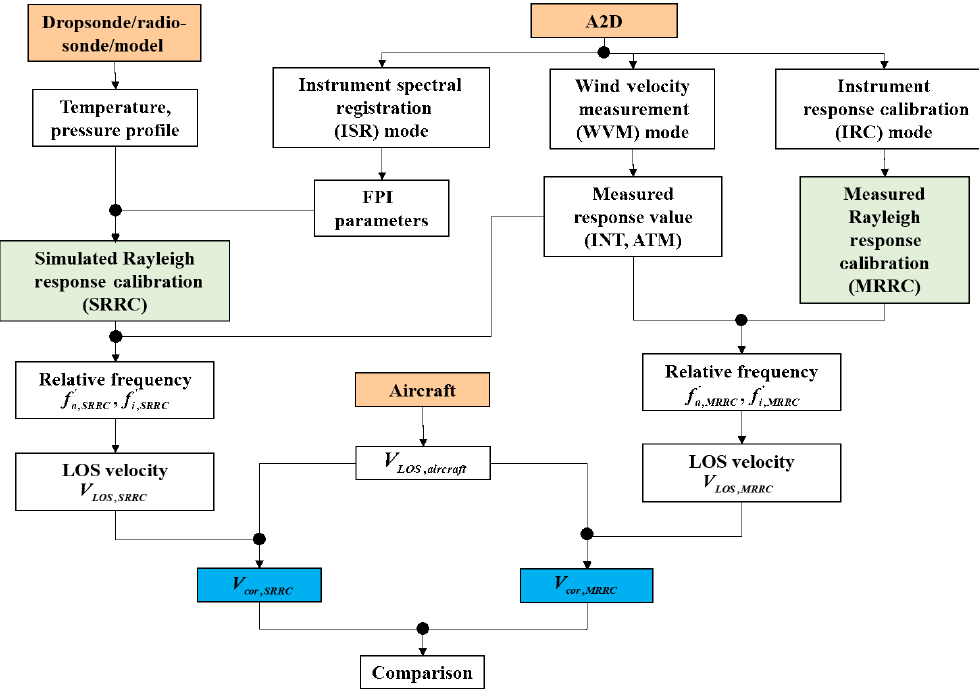
Figure 4. Flowchart of LOS velocity retrieval and comparison between A2D SRRC and MRRC.